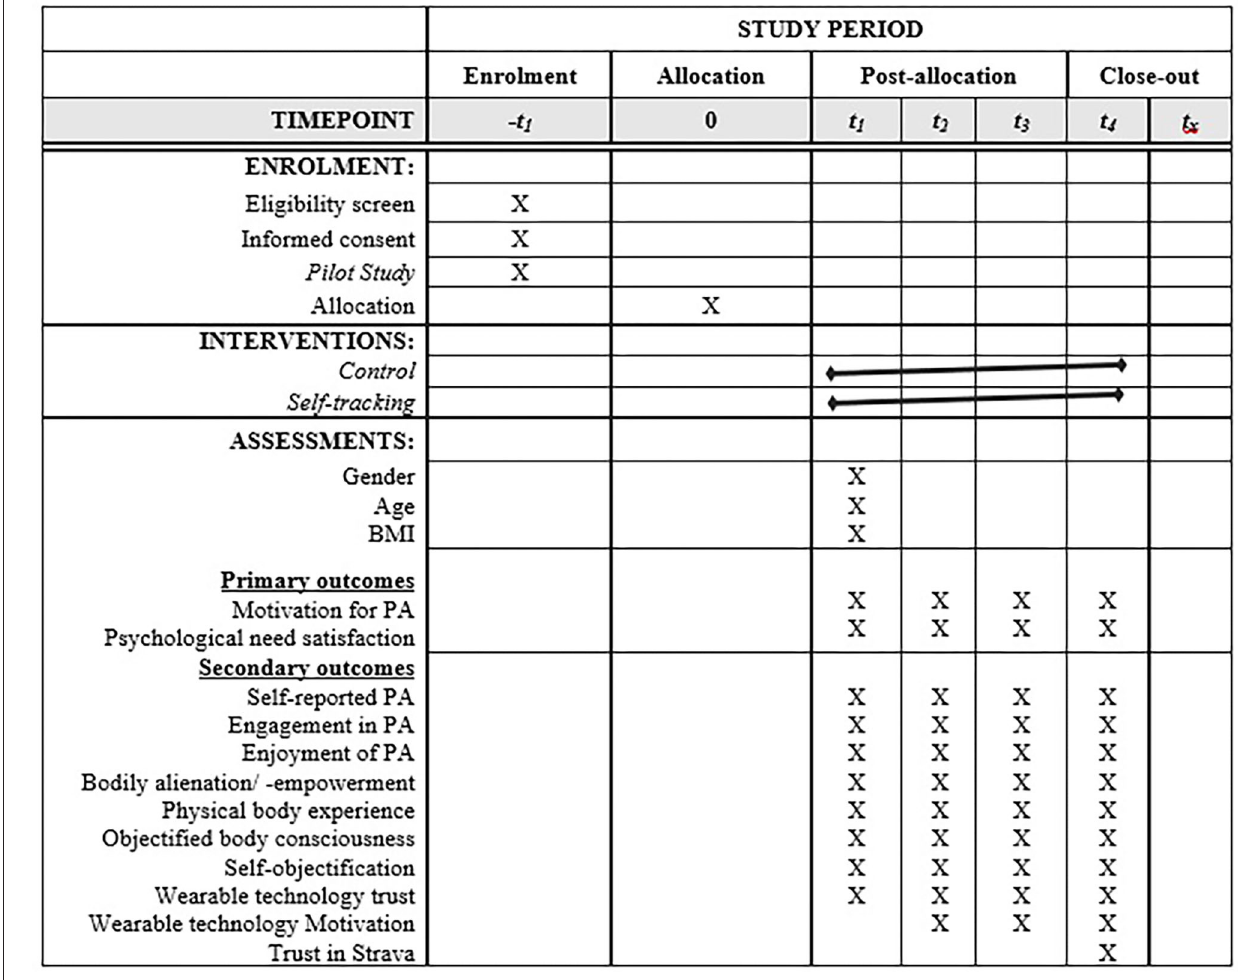
FIGURE 1 | Enrolment, interventions, and assessment in the study